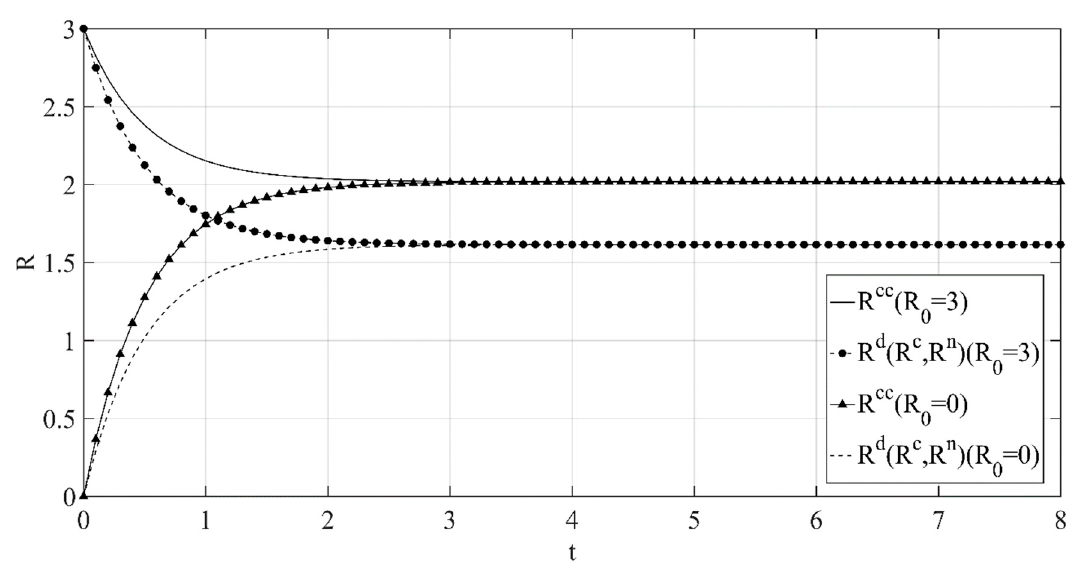
Figure 3. The optimal path of reference low-carbon level over time.